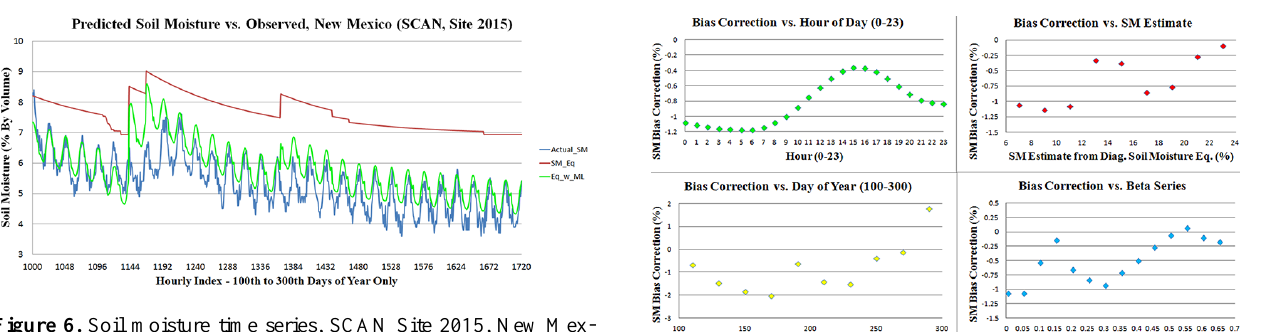
Figure 6. Soil moisture time series, SCAN Site 2015, New Mex- ico (USA), actual soil moisture (blue line), diagnostic soil moisture equation estimate (red line), and diagnostic soil moisture equation with machine learning error correction (green line).